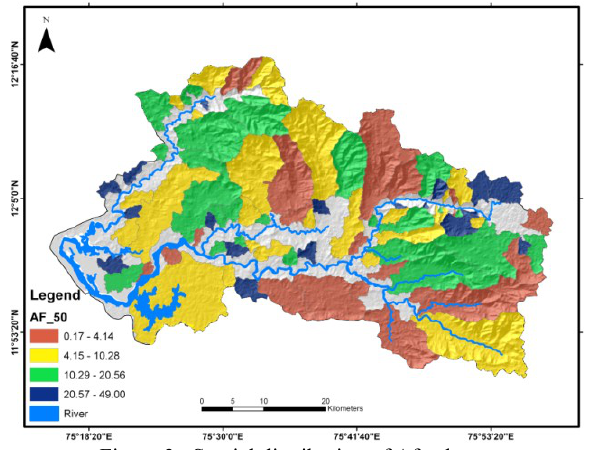
Figure 3. Spatial distribution of Af values.